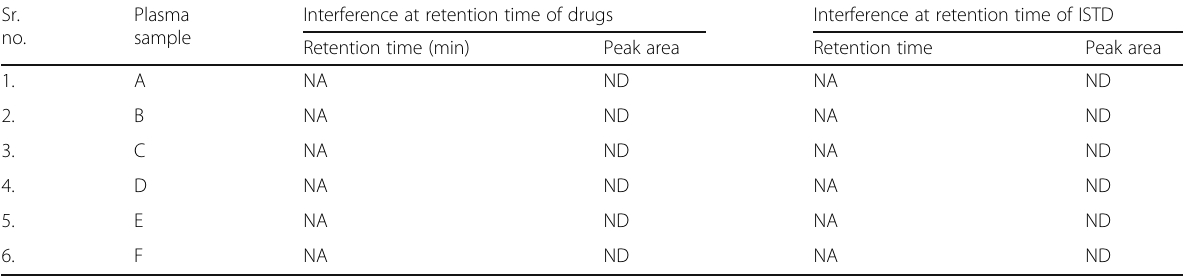
Table 2 Specificity parameters for developed bioanalytical method Sr.